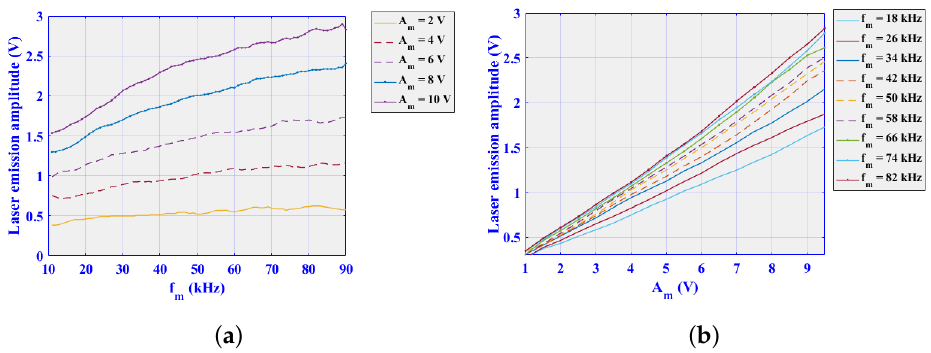
Figure 5. Curves of the voltage of the emission of the LD varying: ( a ) amplitude ( A m ), and ( b ) fre- quency ( f m ).